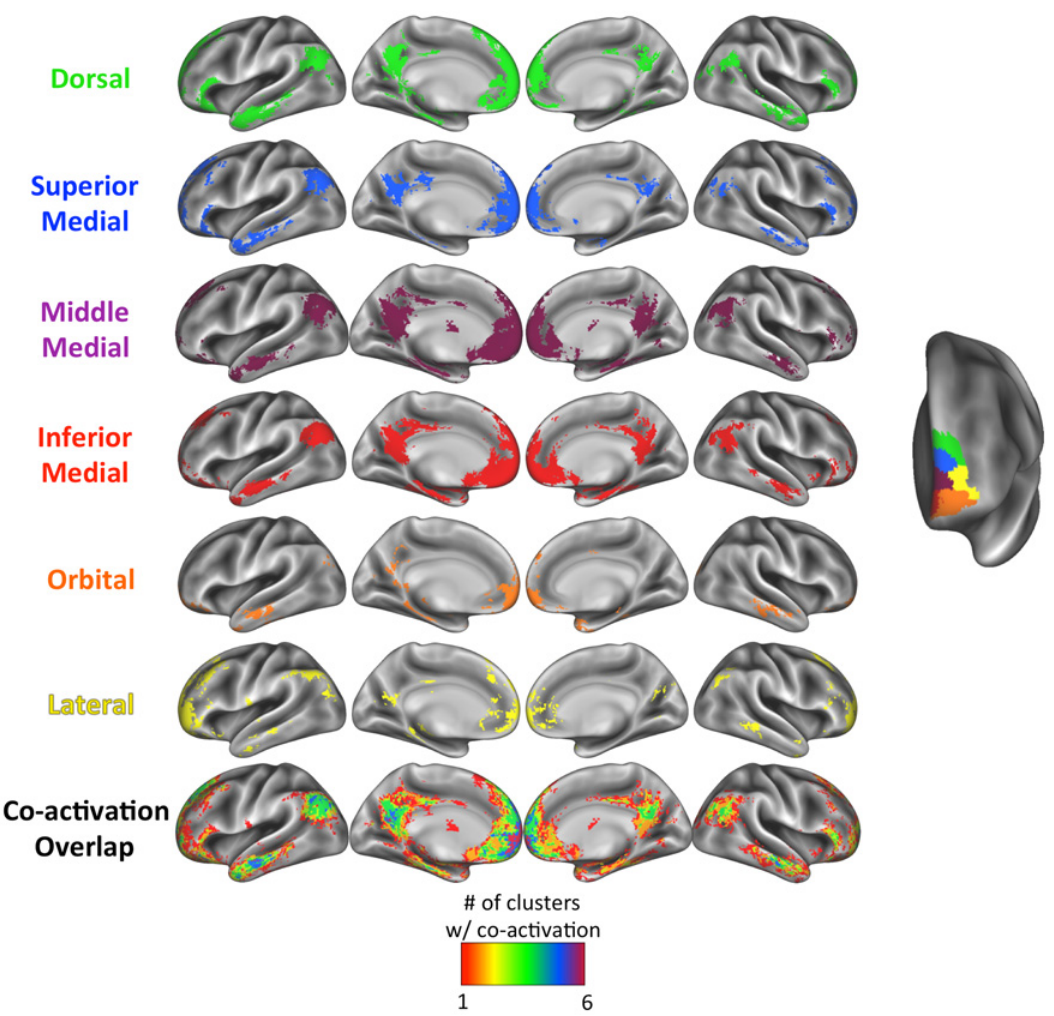
Fig 10. Meta-analytic functional co-activation maps for each cluster of the left K = 6 solution. The colors match the cluster labels in Fig 2 ( K = 6), reproduced on the right. The degree of overlap in the co-activation maps in shown in the bottom row, with the color scale for the overlap shown at the bottom of the